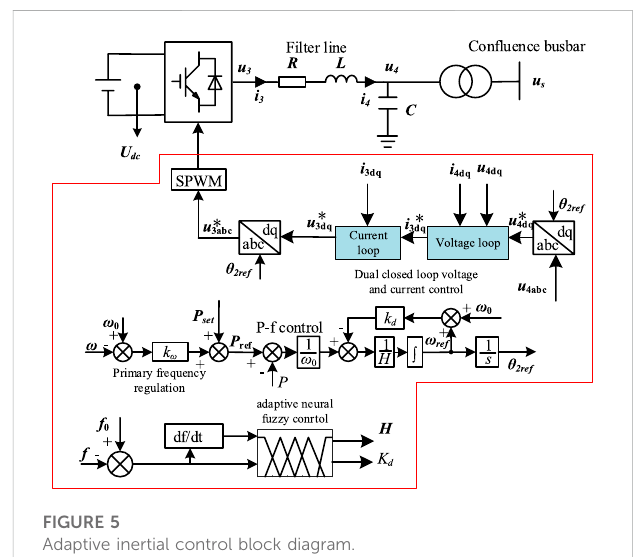
FIGURE 5 Adaptive inertial control block